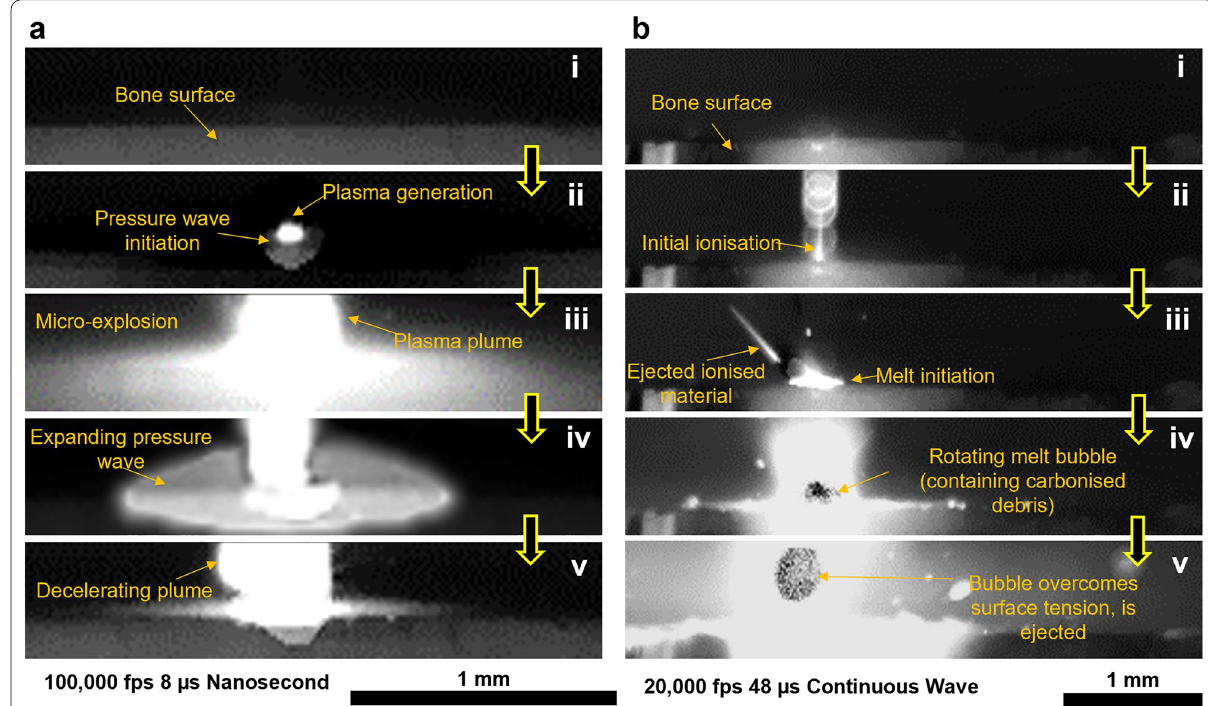
Figure 8 High‑speed camera investigation of material removal mechanisms during laser machining: the bone surface was imaged perpendicular to the beam direction during ( a ) nanosecond pulsed laser machining and ( b ) continuous wave laser machining. Sequence ( a ) was captured at